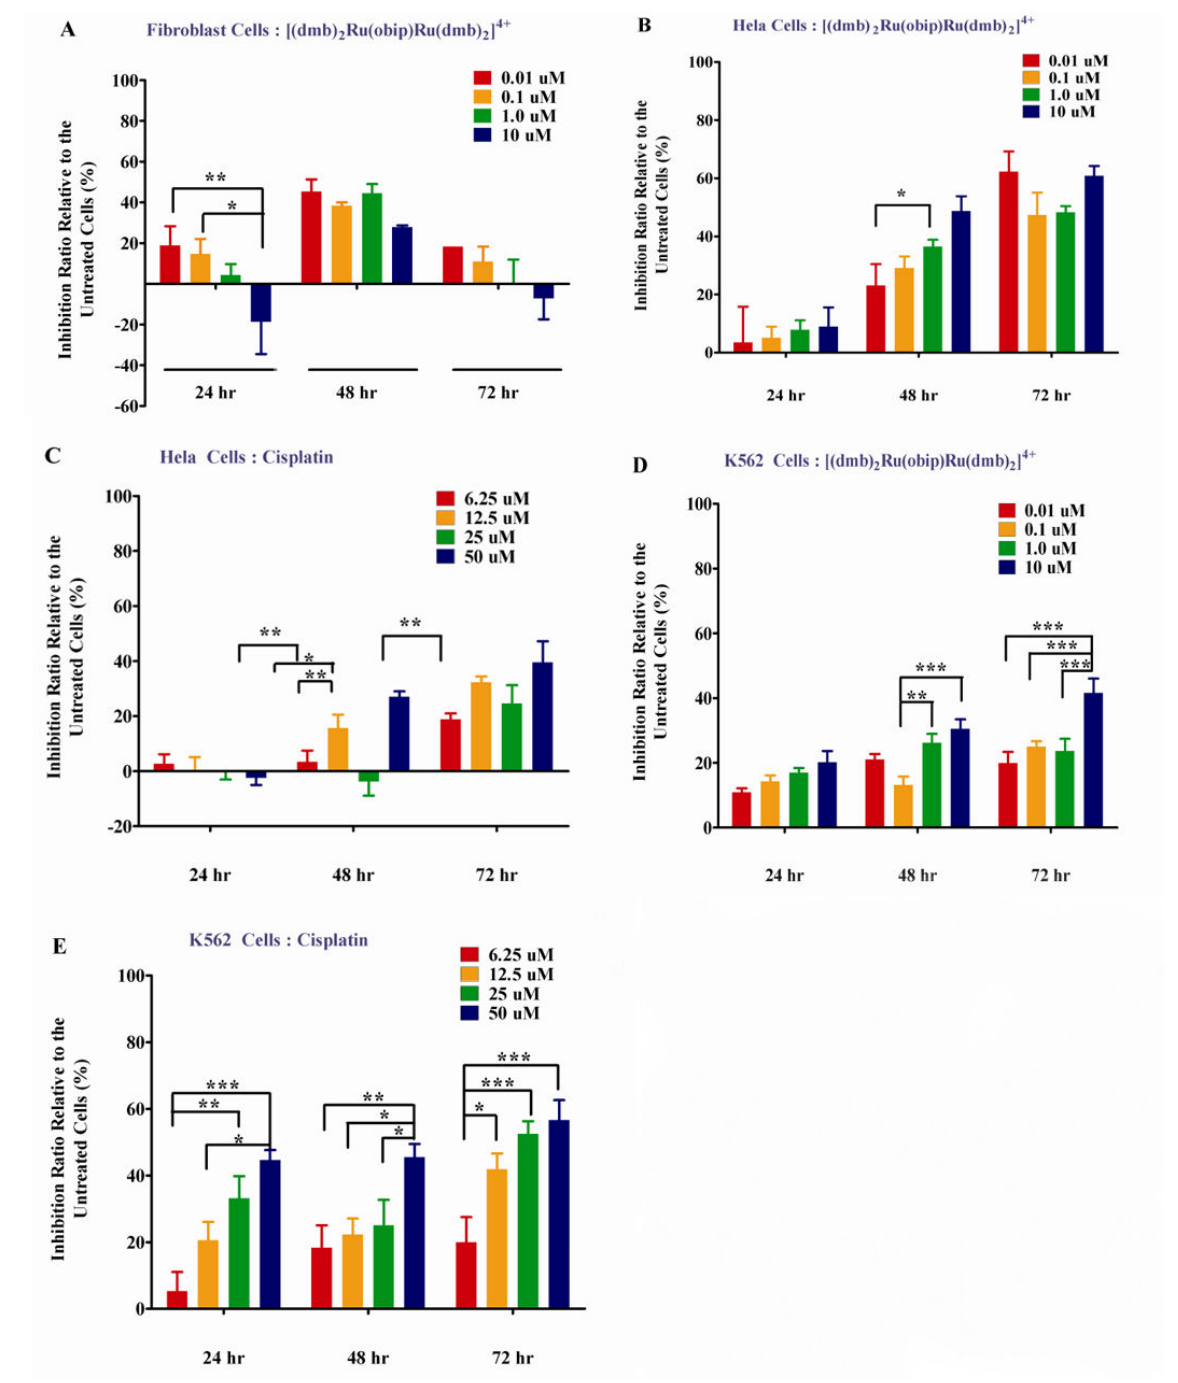
Figure 9. Cytotoxic effects of complexes on cells. MTT assay was performed on human normal fibroblast cells treated with [(dmb) Ru(obip)Ru(dmb) ] 4 A), human cervical cancer Hela cells treated with [(dmb) 2 2 B), Hela cells treated with a clinical chemotherapeutic cisplatin C), K562 cells treated with [(dmb) cells treated with cisplatin respectively at gradient concentrations. The inhibition ratio was collected as the average of triplicate wells relative to that of the untreated wells. Result shown here was the representative one among three independent experiments. Data were presented as mean +/- S.E.M.* means P < 0.05, ** means P < 0.005, *** means P < 0.0001 significant difference was observed by GraphPad Prism5 Two-way RM ANOVA (Bonferroni posttests). doi: 10.1371/journal.pone.0084419.g009 PLOS ONE |